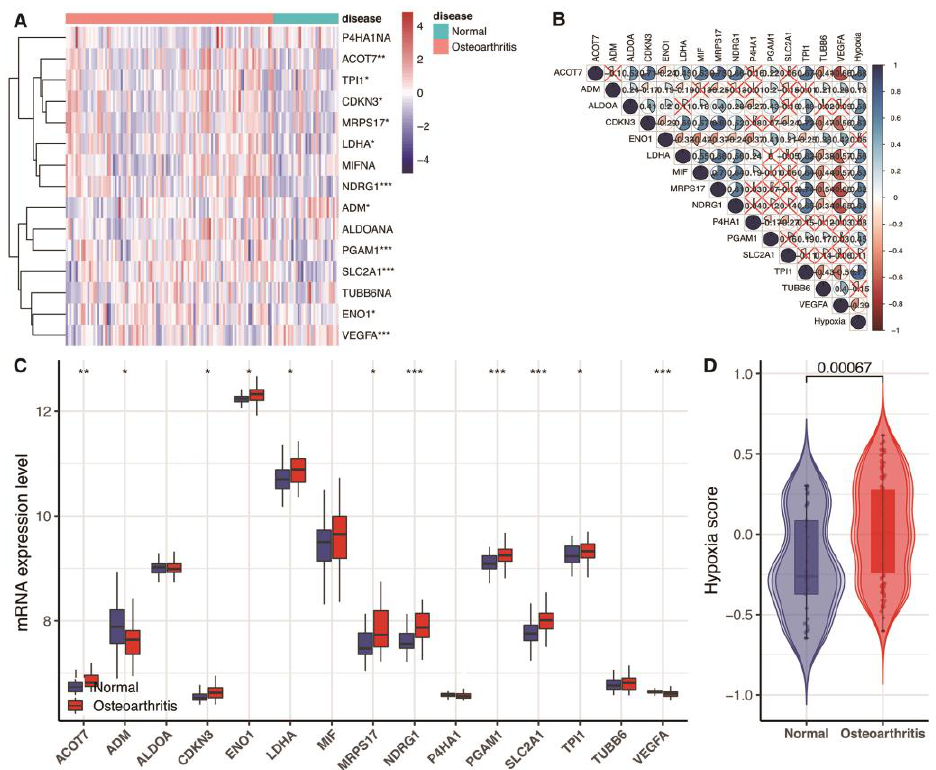
Figure 1. Assessment of hypoxia status in GSE48556. ( A ) Heat map of the expression of 15 hypoxia gene expression signatures. Red represents high expression, and blue represents low expression. ( B ) The correlation between the 15 hypoxia gene expression signatures and hypoxia score. Blue represents positive correlation; red represents negative correlation. ( C ) Box plots show 15 differentially expressed hypoxia gene expression signatures. * p < 0.05; ** p < 0.01; *** p < 0.001; p ≥ 0.05, not significant. ( D ) Violin graphs of hypoxia scores between osteoarthritis and normal samples.